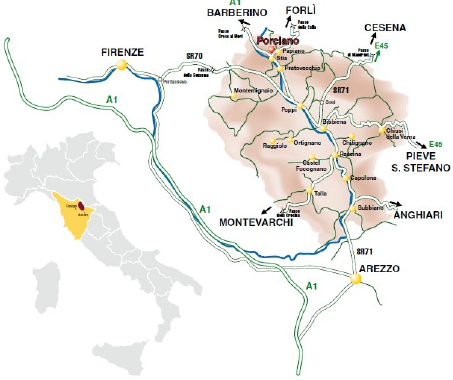
Figure 2: Casentino in Tuscany and Italy